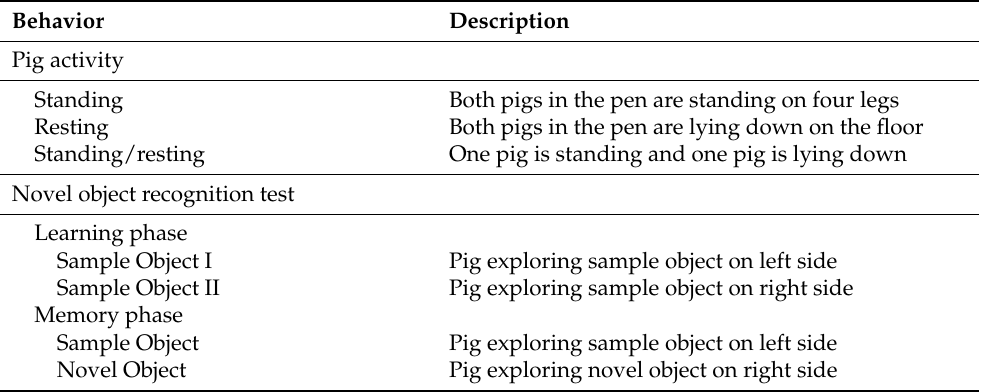
Table 1. Ethograms for novel object recognition test and pig activity in the home pens. Behavior Both pigs in the pen are standing on four legs Both pigs in the pen are lying down on the